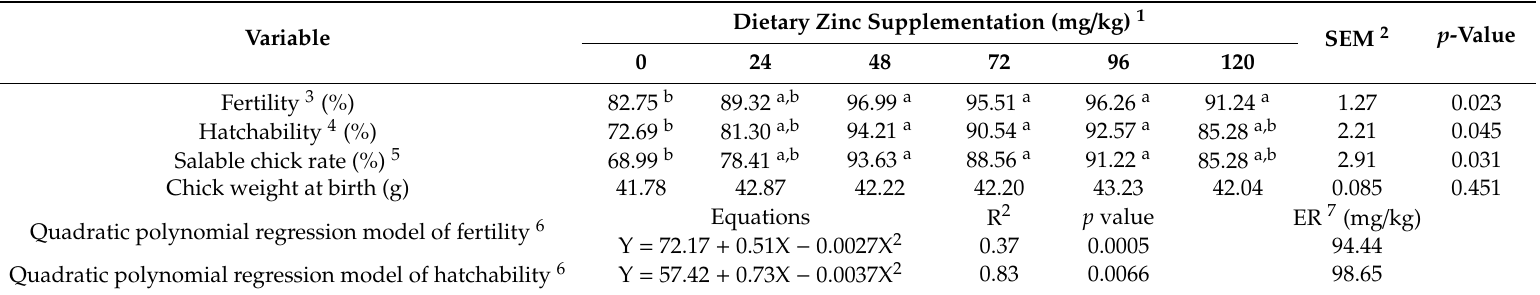
Table 4. E ff ects of dietary zinc supplementation on reproductive performance of yellow-feathered broiler breeders aged 65